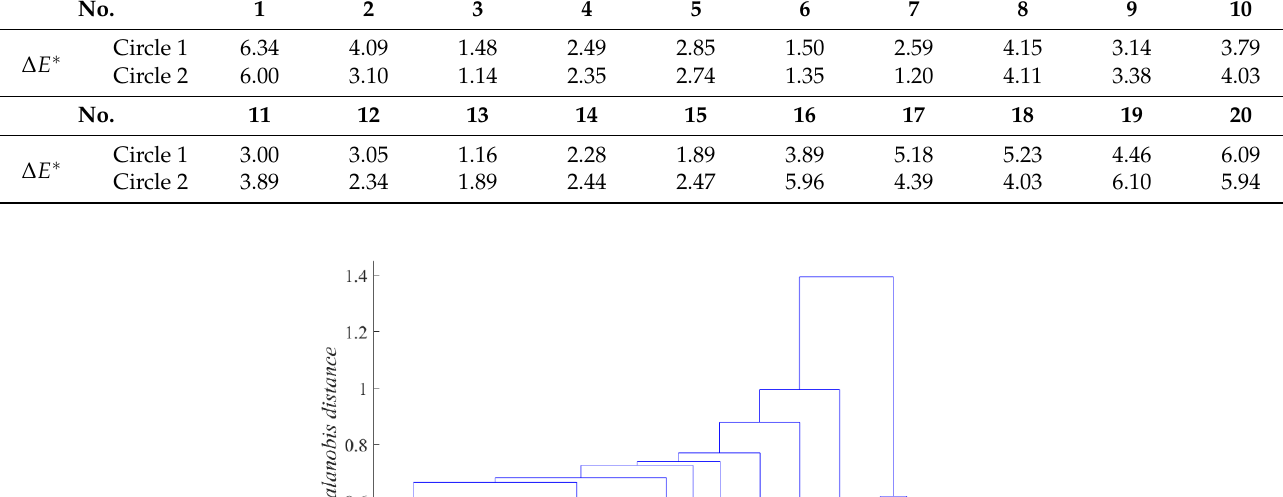
Table 2. Chromatic aberration ∆ E ∗ of the 8 mm circles in Circle 1 and Circle 2 before the correction. No.